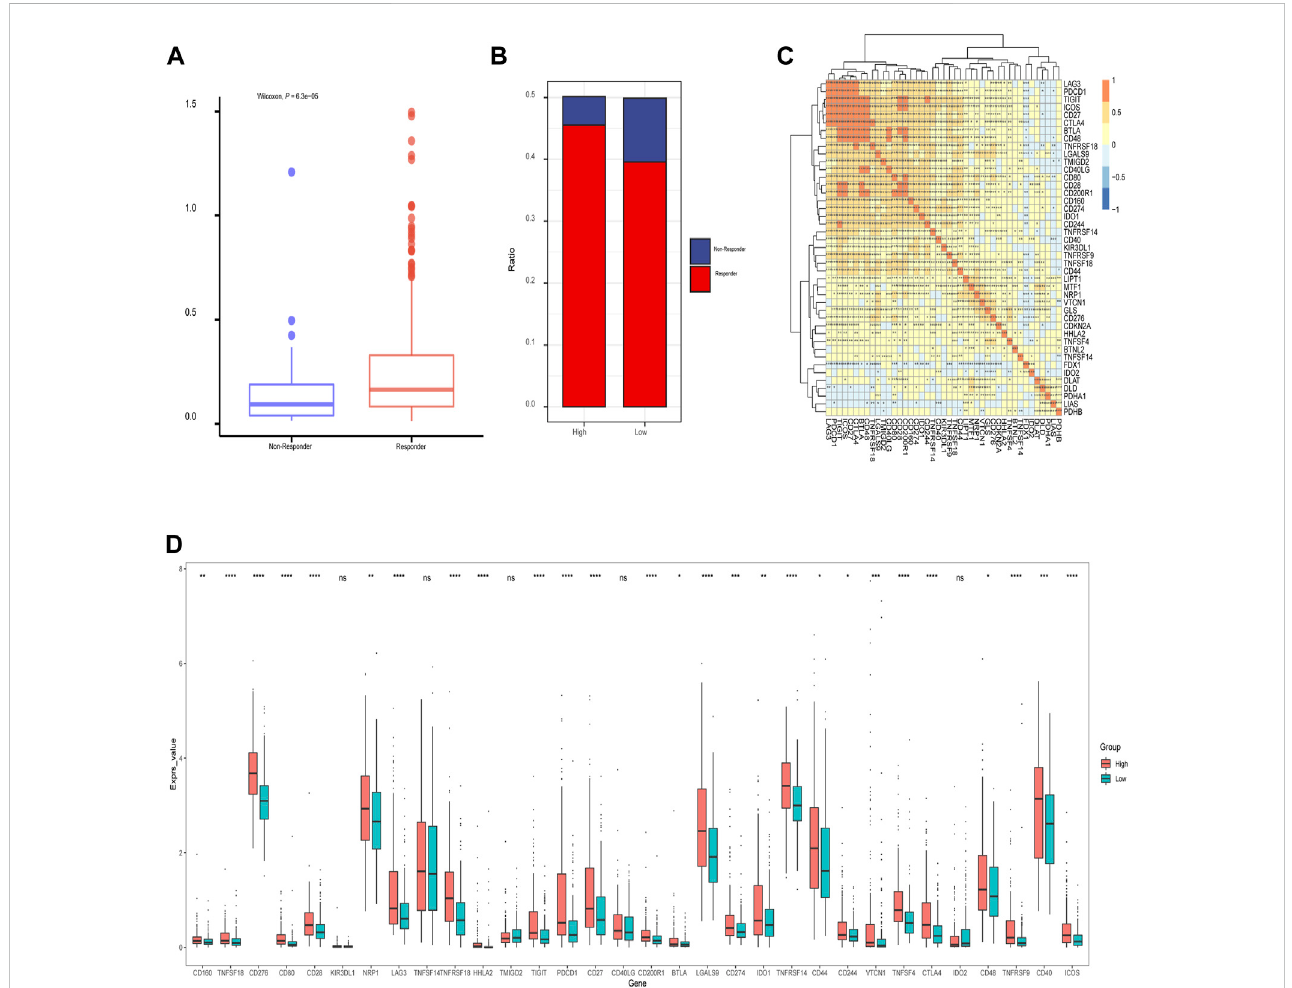
FIGURE 10 The relationshipof immunotherapy responses and immune checkpoints indifferentcuproptosis-related genes(CRGs)signature groups. (A) Differences in CRGs signature of patients with different treatment outcomes (bene fi cial or non-bene fi cial) (B) the proportion of immunotherapy bene fi t and non-bene fi t between the two CRGs groups; (C) Heatmap of correlation analysis between CRGs groups and different immune checkpoints (*represents p < 0.05; *represents p < 0.01; **represents p < 0.001; ***represents p < 0.001); (D) Differences between the immune checkpoints and two CRGs groups (ns: p > 0.05; *: p < 0.05; **: p < 0.01; ***: p < 0.001; ****: p <